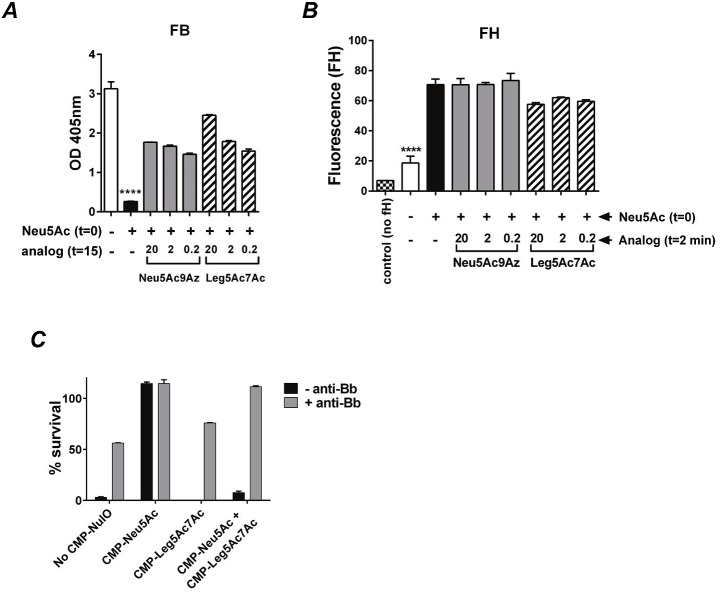
CMP-Neu5Ac9Az and CMP-Leg5Ac7Ac block CMP-Neu5Ac-mediated alternative pathway inhibition despite continued factor H (FH) binding.
N. gonorrhoeae (Ng) F62 ΔlgtD was incubated in media that contained CMP-Neu5Ac (20 μg/ml), followed by addition of either CMP-Neu5Ac9Az or CMP-Leg5Ac7Ac (20, 2 or 0.2 μg/ml). Bacteria were grown for 2 h and factor B (FB) binding (A) to bacteria following incubation with 10% normal human serum (NHS) was measured by whole cell ELISA as described in Fig 7. Binding to purified FH (B) was measured by flow cytometry using polyclonal goat anti-human FH. The Y-axis represents OD405nm for FB binding and median fluorescence of FH binding. Mean (SD) of two independent observations is shown for each measurement. ****, P<0.0001 (ANOVA) compared to other reactions. C. Alternative pathway activation is required for maximal killing of Ng F62 ΔlgtD grown in CMP-Leg5Ac7Ac-containing media. Bacteria were grown in media alone, or media containing CMP-Neu5Ac (20 μg/ml) or CMP-Leg5Ac7Ac (20 μg/ml) or both CMP-NulOs together (each at 20 μg/ml) as indicated on the X-axis. Serum bactericidal assays were performed using normal human serum (all complement pathways intact; black bars) or NHS treated with an anti-factor Bb mAb that blocks FB function (AP inactivated, but classical and lectin pathways intact; grey bars). Y-axis, percent survival. The mean (range) of two independent experiments is shown.